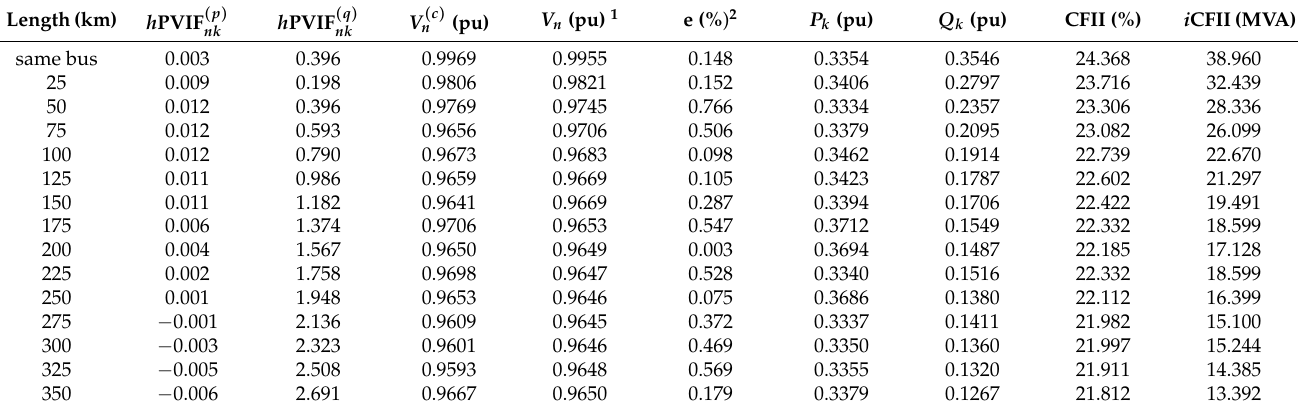
Table 5. Local CFII values in the h MIF system—VSC complex power.